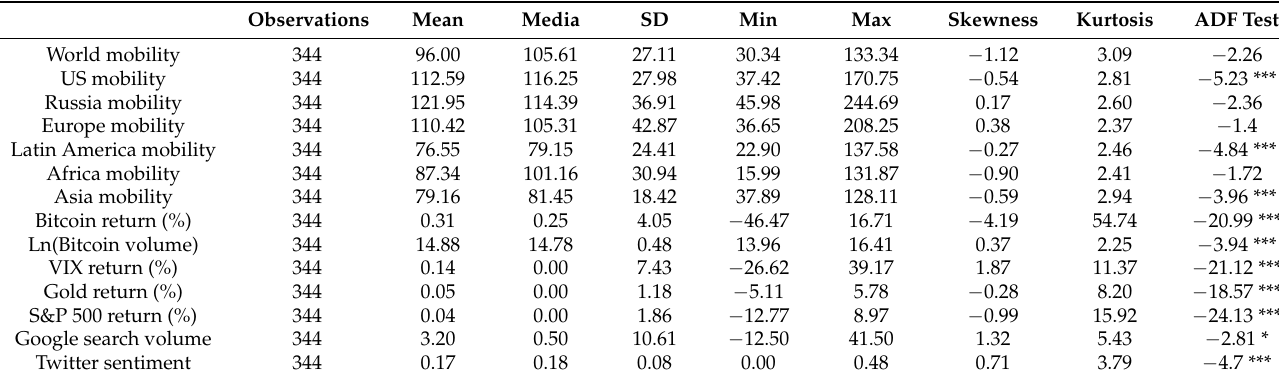
Table 1. Descriptive statistics of key